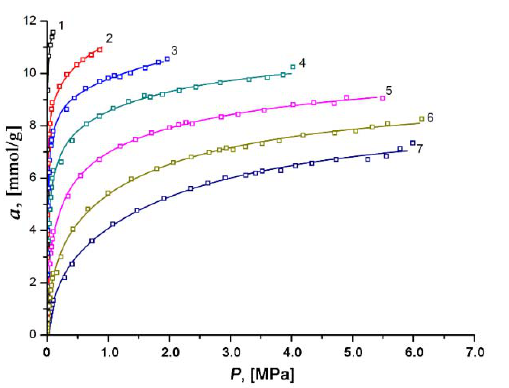
Figure 8. Dependencies of absolute xenon adsorption on the SiC-AC adsorbent on pressure at temperatures, K: 1—178; 2—216; 3—243; 4—273.15; 5—313; 6—353; and 7—393. Symbols are experimental data; solid lines are the approximation results by Equation (6) proposed in [75]. For Xe storage, the SiC ‐ AC sorption properties are competitive with those of the po ‐ rous materials (MOF, polymer cage, zeolite, and AC) described in the literature and sum ‐ marized in Table 3. Table 3. Comparison of the low ‐ pressure Xe adsorption values in MOF (No. 1–3), porous organic cage (No. 4), zeolites (No. 5–7), and activated carbons (No. 8–10).